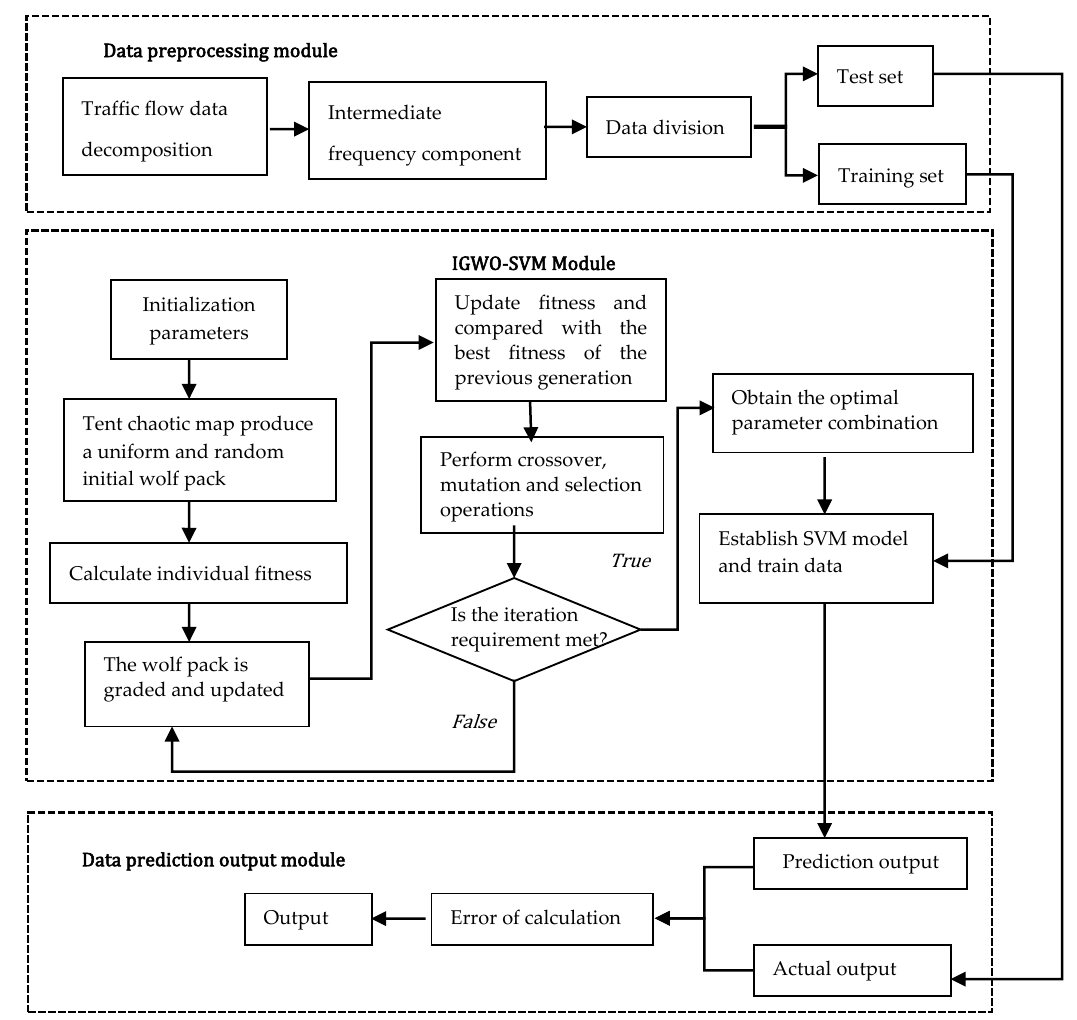
Figure 2. Periodic component prediction flowchart based on IGWO-SVM.